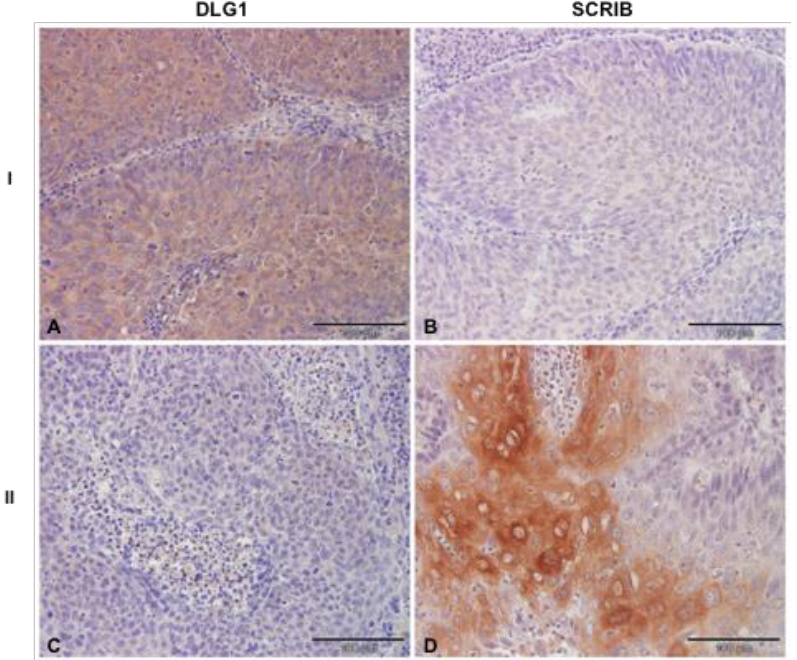
Figure 4. DLG1 and SCRIB protein expression levels in HPV16-positive OPSCC. Paraffin-embedded biopsies were immunostained with anti-DLG1 and anti-SCRIB antibodies, counterstained with hematoxylin, and visualized by a light microscope. Representative images: I. Pattern observed in the majority of samples: ( A ) positive cytoplasmic DLG1 immunoreactivity; ( B ) negative SCRIB immunoreactivity. II. Conflicting pattern observed in several samples: ( C ) negative DLG1 immunore- activity; ( D ) positive SCRIB immunoreactivity. Scale bars = 100 µ